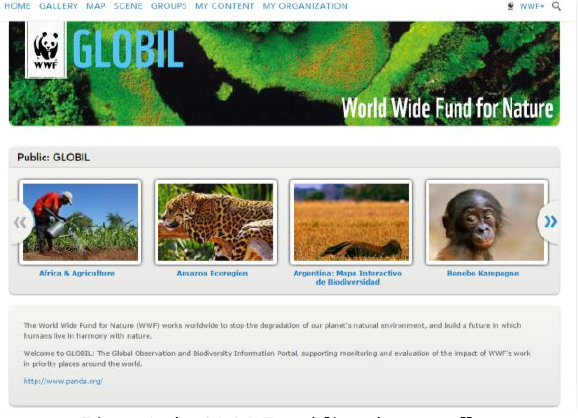
Figure 1. the GLOBIL public web map gallery